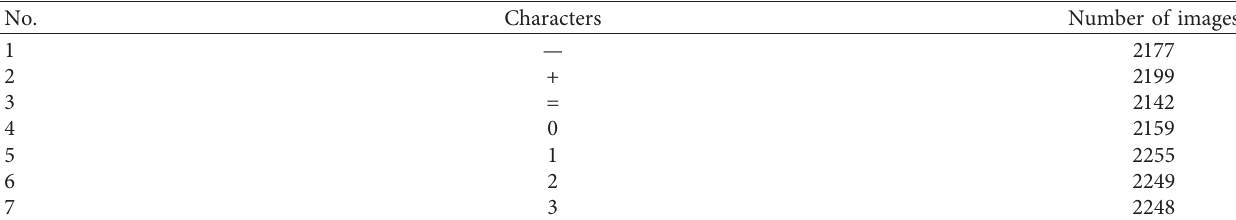
Table 2: Number of images of each letter to be prepared for